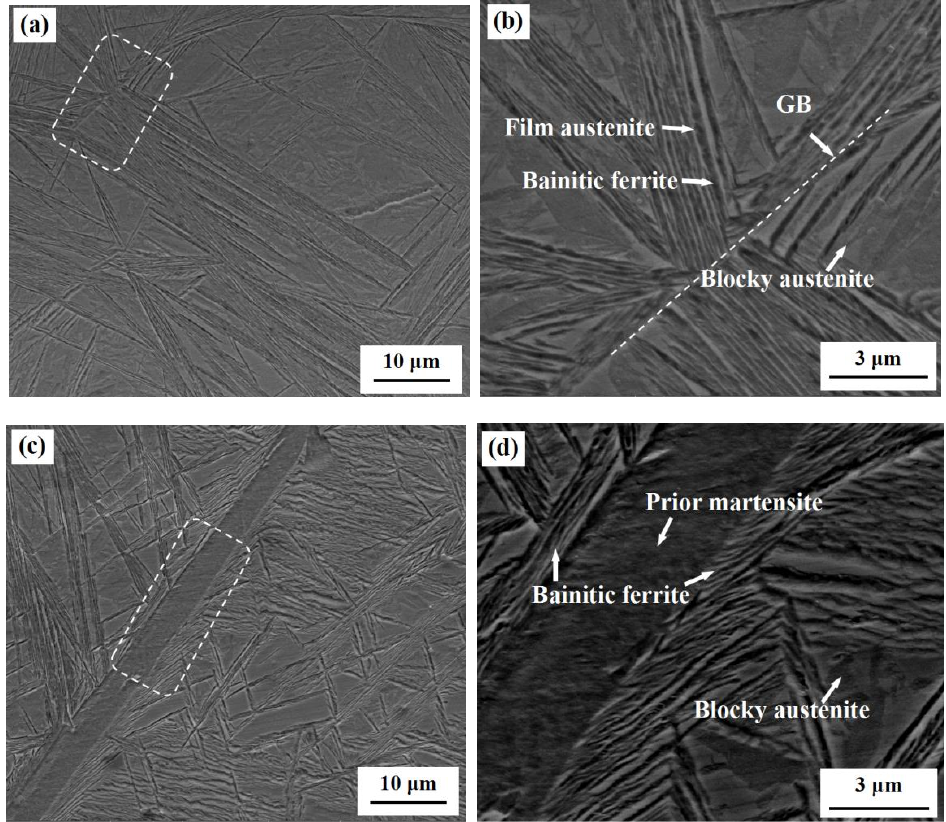
Figure 6. SEM microstructures of ( a , b ) DIT and ( c , d ) QBT specimens after in situ observation. ( b , d ) are enlarged images of the framed area in ( a , c ), respectively.